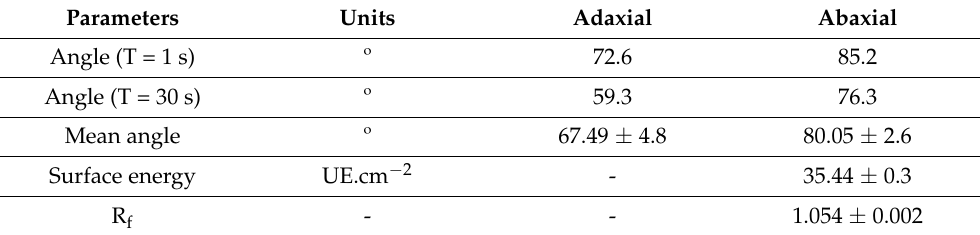
Table 5. Contact angle and surface energy measurements for both sides of the leaf.